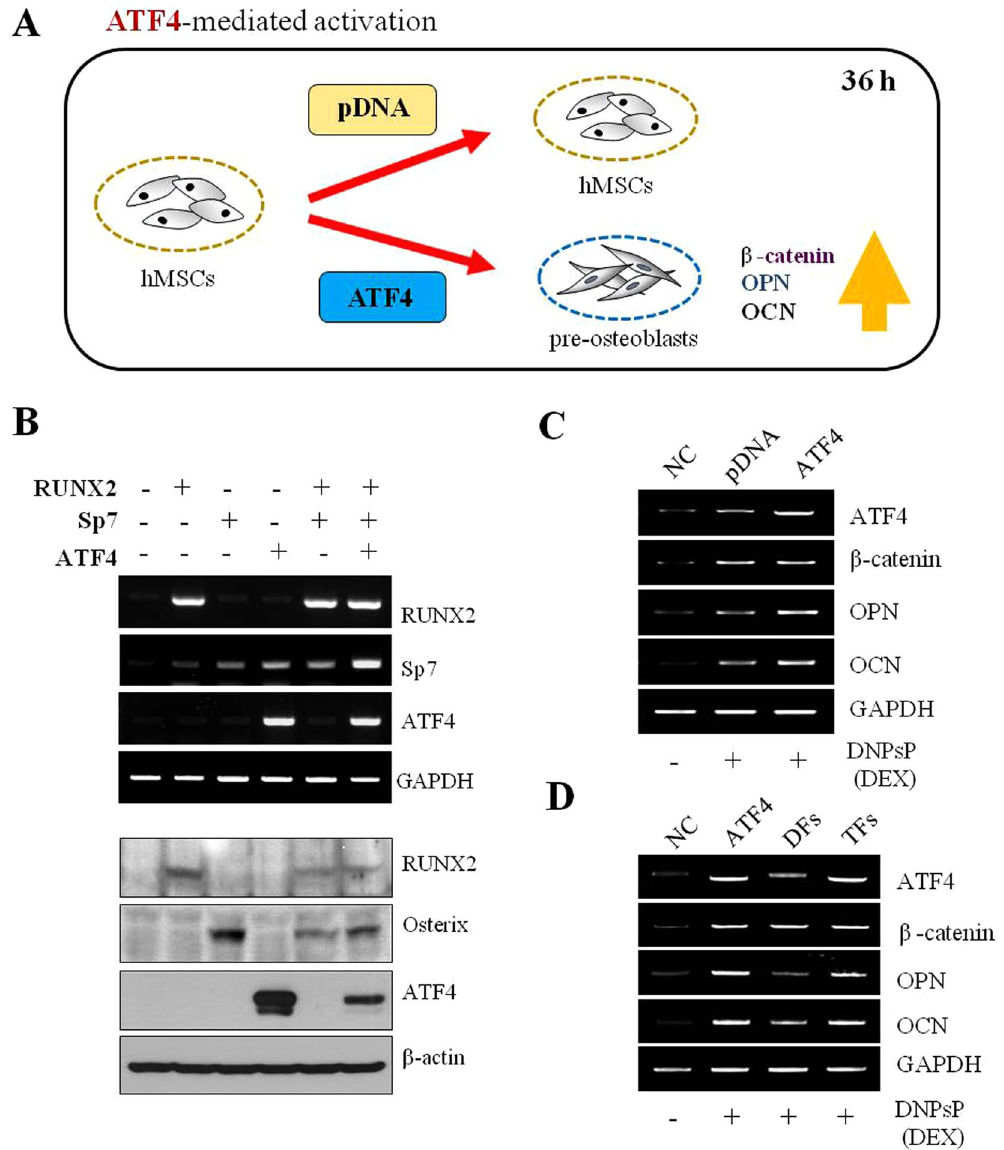
Figure 3. RT-PCR analysis of hMSCs treated with DNPsP coated with pDNA or pATF4. ( A ) Schematic illustration of the effects of treatment with DNPsP coated with pDNA orpATF4 on hMSCs. ( B ) RT-PCR and Western blot analysis of mRNA and protein levels in hMSCs transfected with one, two, and three genes. ( C ) RT-PCR analysis of mRNA expression levels of ATF4, CTNNB1, OPN, and OCN in hMSCs treated with DNPsP coated with pDNA or pATF4. ( D ) RT-PCR analysis of mRNA expression levels of ATF4, CTNNB1, OPN, and OCN in hMSCs treated with DNPsP coated with pDNAs harboring ATF4, RUNX2 plus SP7, or all three